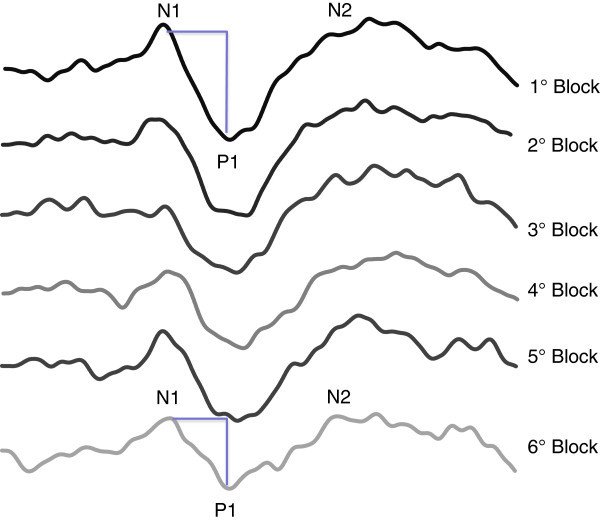
The time-dependent changes of N1P1 and P1N2 components of visual evoked potentials in a healthy subject. Over six blocks of 100 averaged single trial responses a reduction in amplitude of both components is shown, in the representative example.